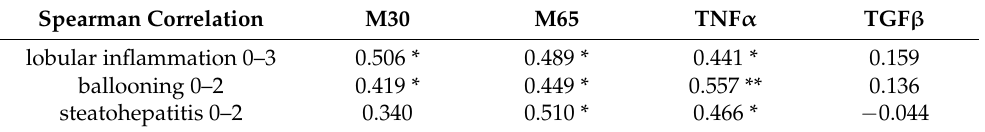
Table 3. Spearman correlations of histology with cell death, TNF- a , TGF-b in aera of HCV patients. Spearman Correlation M30 M65 TNF α TGF β lobular inflammation 0–3 0.506 * 0.489 * 0.441 * 0.159 ballooning